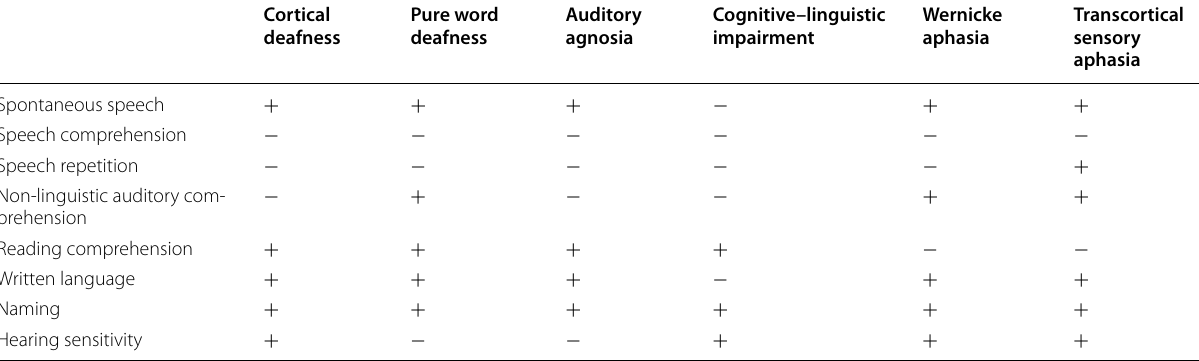
Table 1 Differential diagnosis of cortical